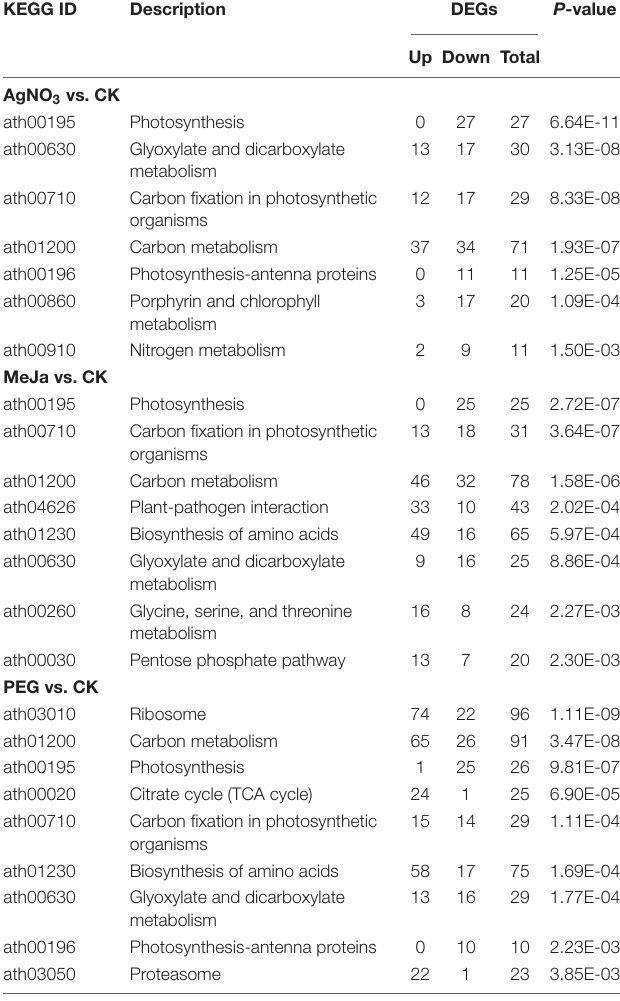
TABLE 3 | KEGG pathway enrichment analysis for differentially expressed genes